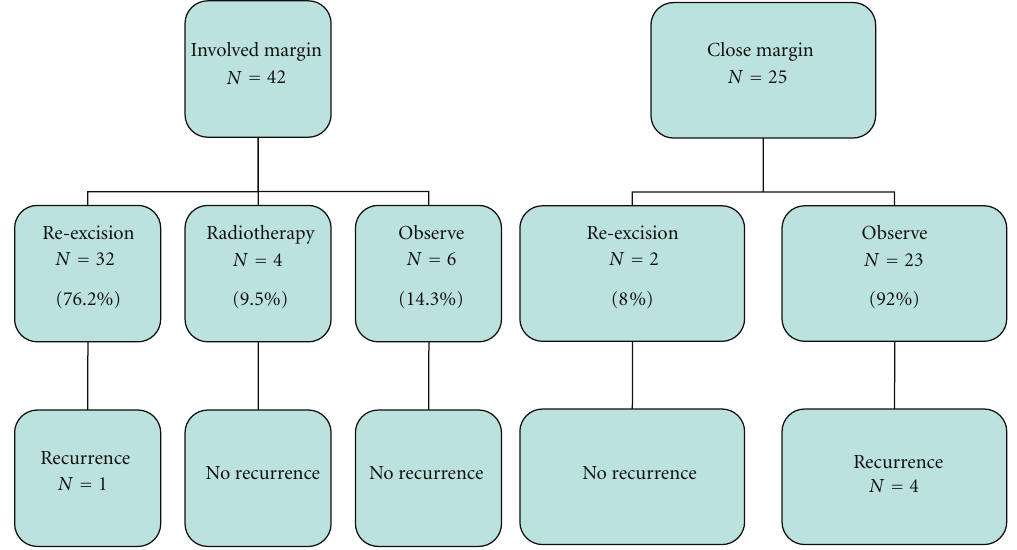
Figure 5: Management of patients with involved and close margins and associated recurrence